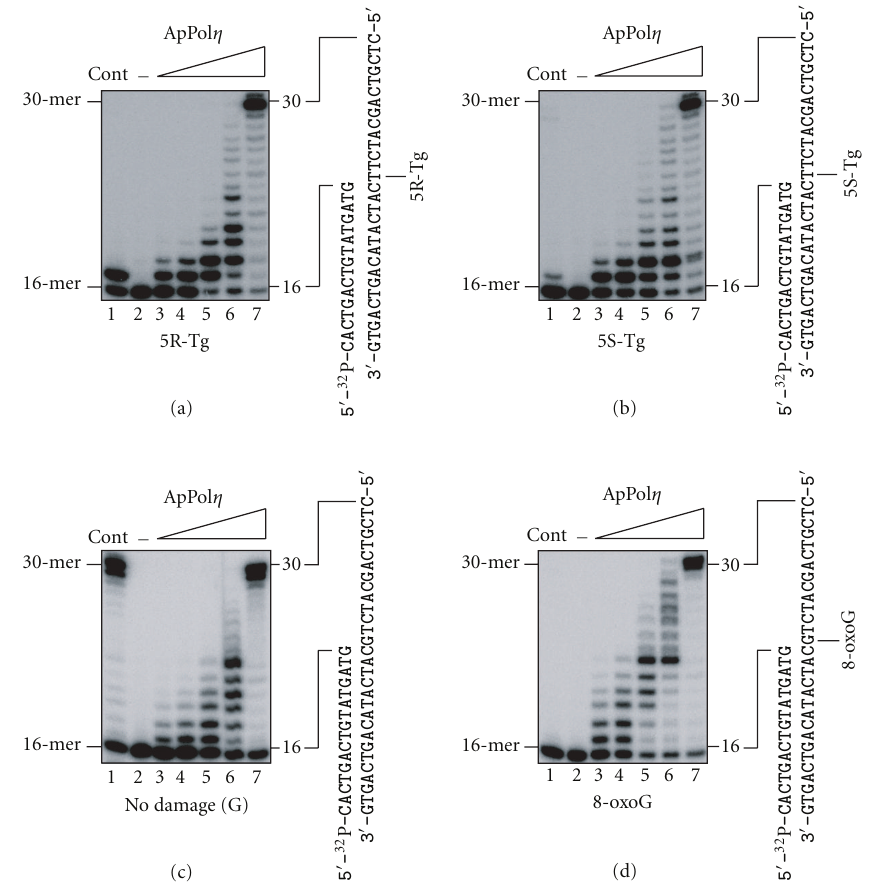
Figure 5: TLS by ApPol η past 5 R -Tg, 5 S -Tg, and 8-oxoG. Increasing amounts of ApPol η (12, 24, 59, 118, 588fmol in lanes 3–7, resp.) were incubated with 40 nM of the primer-templates indicated beside each panel. The templates contained 5 R -Tg (a), 5 S -Tg (b), undamaged G (c), and 8-oxoG (d). The samples for lanes 1 and 2 contained 0.1 U T7 DNA polymerase and no enzyme, respectively. The reactions were incubated at 37 ◦ C for 20 minutes, and then were subjected to 15% polyacrylamide/7.5 M urea gel electrophoresis. The autoradiograms of the gels are shown.